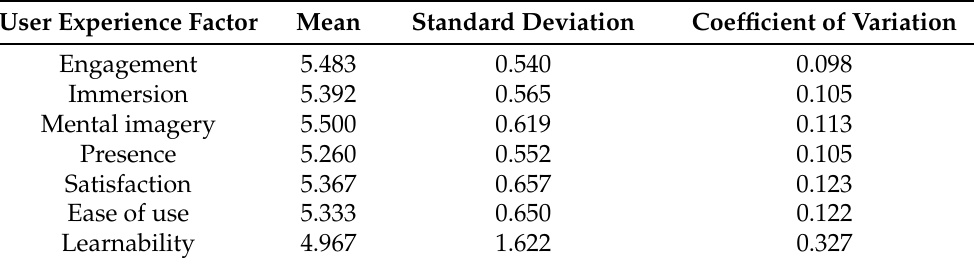
Table 2. Mean values, standard deviation and coefficient of variations of the scores of the user experience factors.